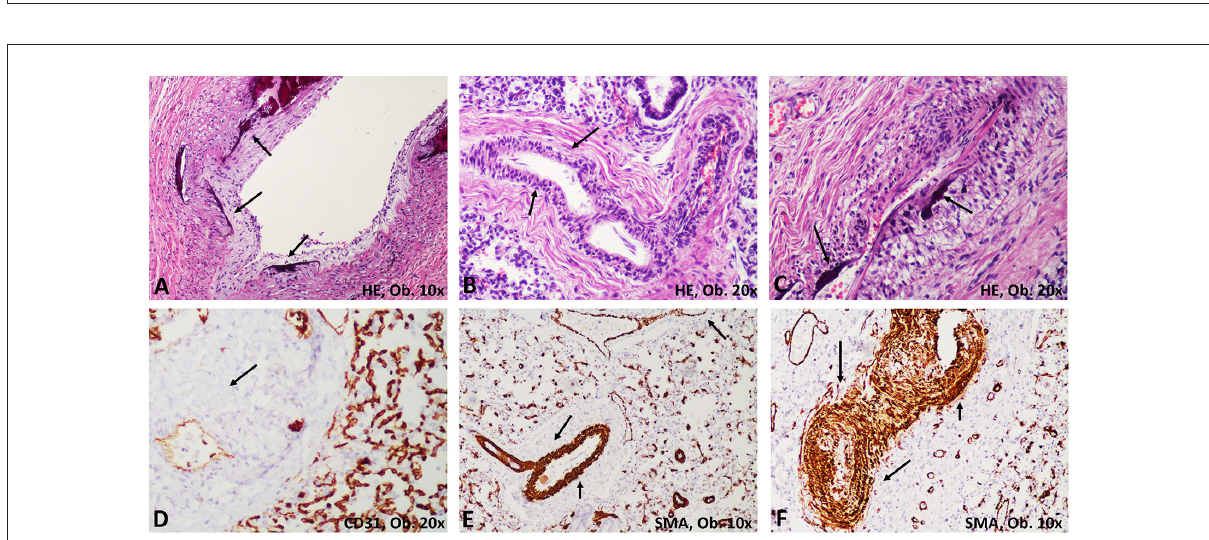
FIGURE2 Histological modifications of the pulmonary arteries (arrows). (A) Calcifications of the lamina elastica; (B,C) Thickening of the intima with calcifications and stenosis of the arterial lumen. (D) The proliferated cells are negative for CD31. (E,F) Compared with normal arteries, marked proliferation of myofibroblasts is emphasized with smooth muscle actin